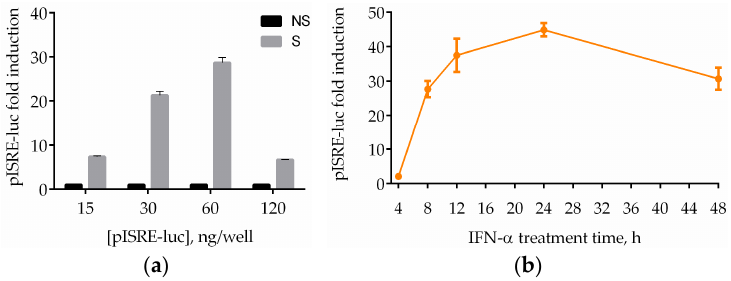
Figure 1. Miniaturized luciferase reporter gene assay in 96-well plates. ( a ) Human embryonic kidney 293T (HEK293T) cells were transfected with 15, 30, 60, and 240 ng of pISRE-luc per well. Twenty-four hours after transfection, cells were stimulated (S) or not (NS) with interferon- α (IFN- α ) for IFN signaling pathway activation. After 8 h, cells were lysed and luciferase activity was measured; ( b ) HEK293T cells were transfected with 60 ng/well of pISRE-luc. Twenty-four hours after transfection, cells were stimulated with IFN- α . After 4, 8, 12, 24, 48 h, cells were harvested and luciferase activity was measured. Results are shown as pISRE-luc fold induction of stimulated cells over the not-stimulated control. Error bars indicate the mean ±